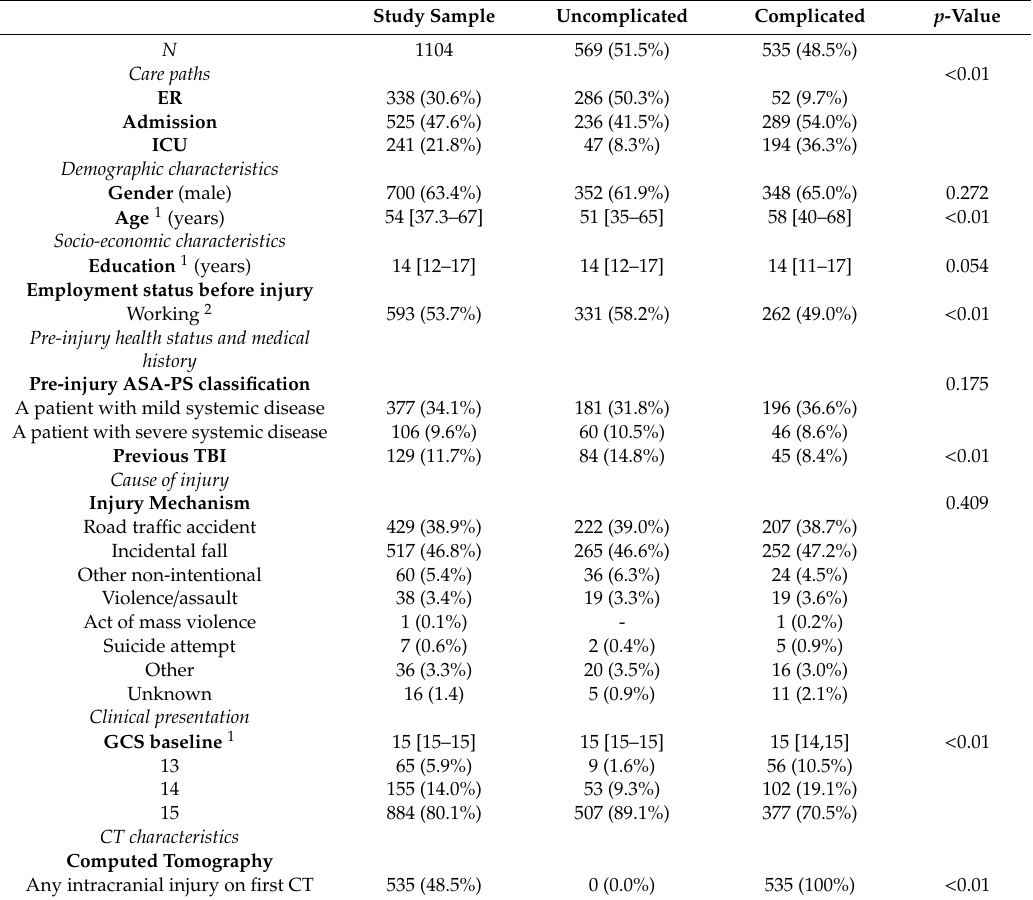
Table 1. Characteristics of the study